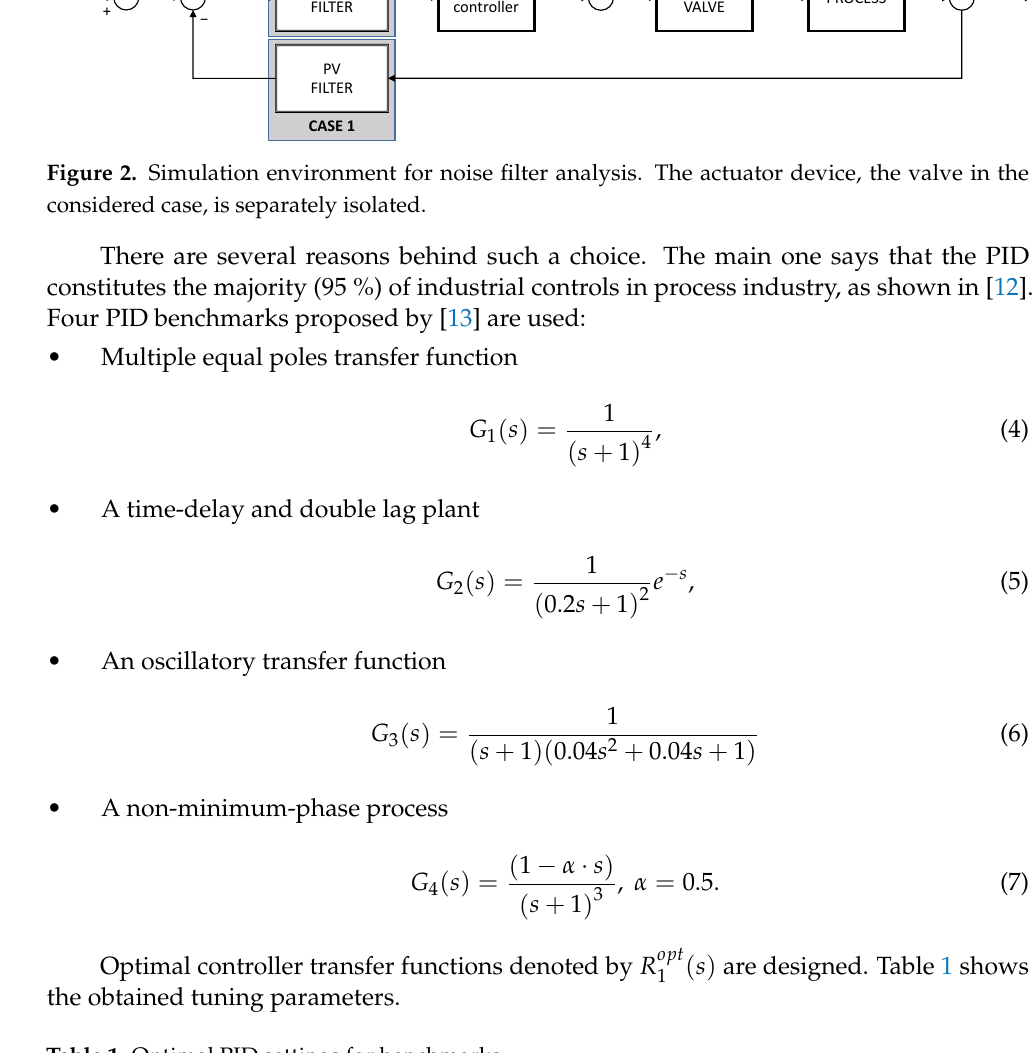
Table 1. Optimal PID settings for